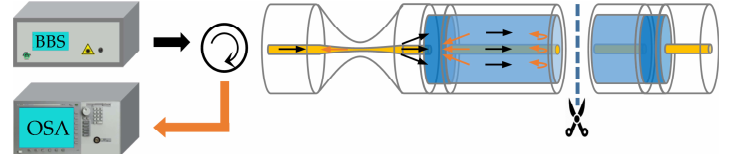
Figure 8. Schematic and experimental setup of TMDM with a double-pass structure.